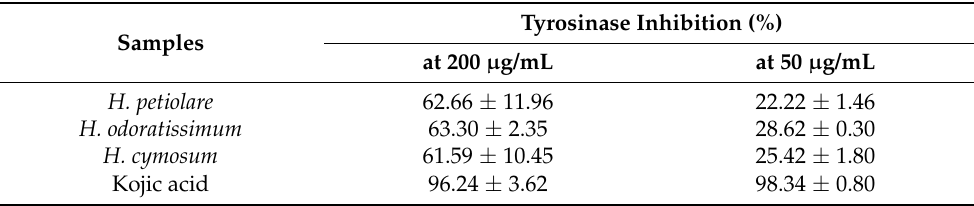
Table 7. Summary of the tyrosinase inhibition assay results for the Helichrysum EOs at 200 µ g/mL and 50 µ